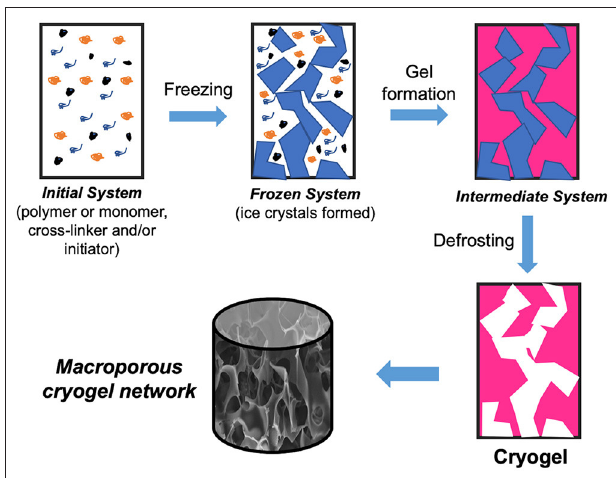
FIGURE 1 | Cryogel fabrication scheme: initial system (gel starting material is cooled to below freezing point); frozen system (ice crystals form and solutes concentrate in non-frozen zones); intermediate system (gel is created in the non-frozen liquid between ice crystals); cryogel is formed after